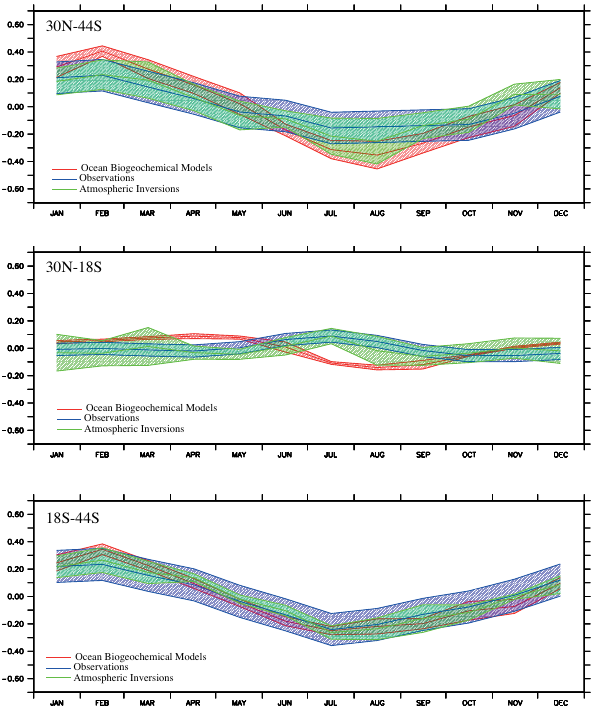
Fig. 6. Seasonal cycle anomaly of the Indian Ocean CO 2 flux (PgCyr − 1 ) from observations, ocean biogeochemical models, and atmospheric inversions for the entire Indian Ocean (30 ◦ N–44 ◦ S upper), northern Indian Ocean (30 ◦ N–18 ◦ S middle) and the south- ern Indian Ocean (18–44 ◦ S;